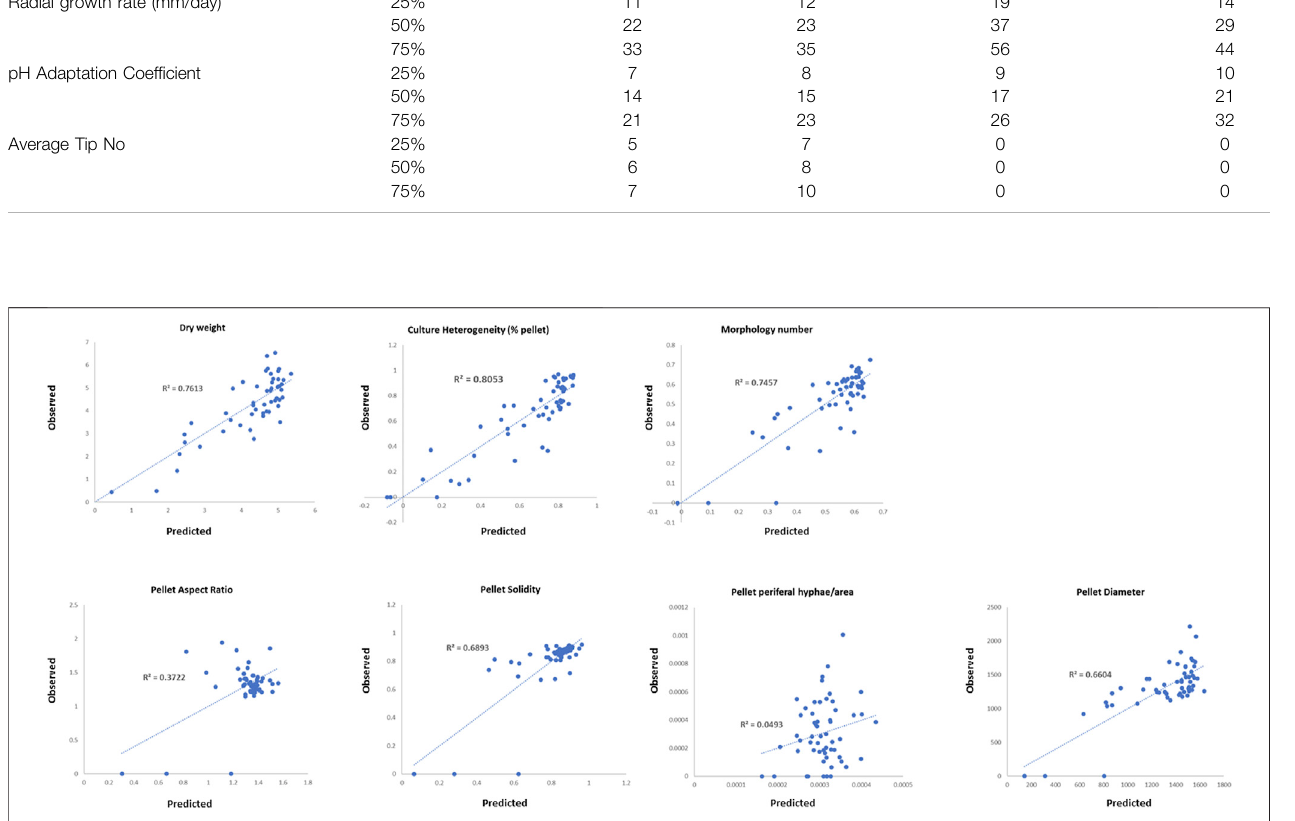
Frontiers in Bioengineering and Biotechnology |